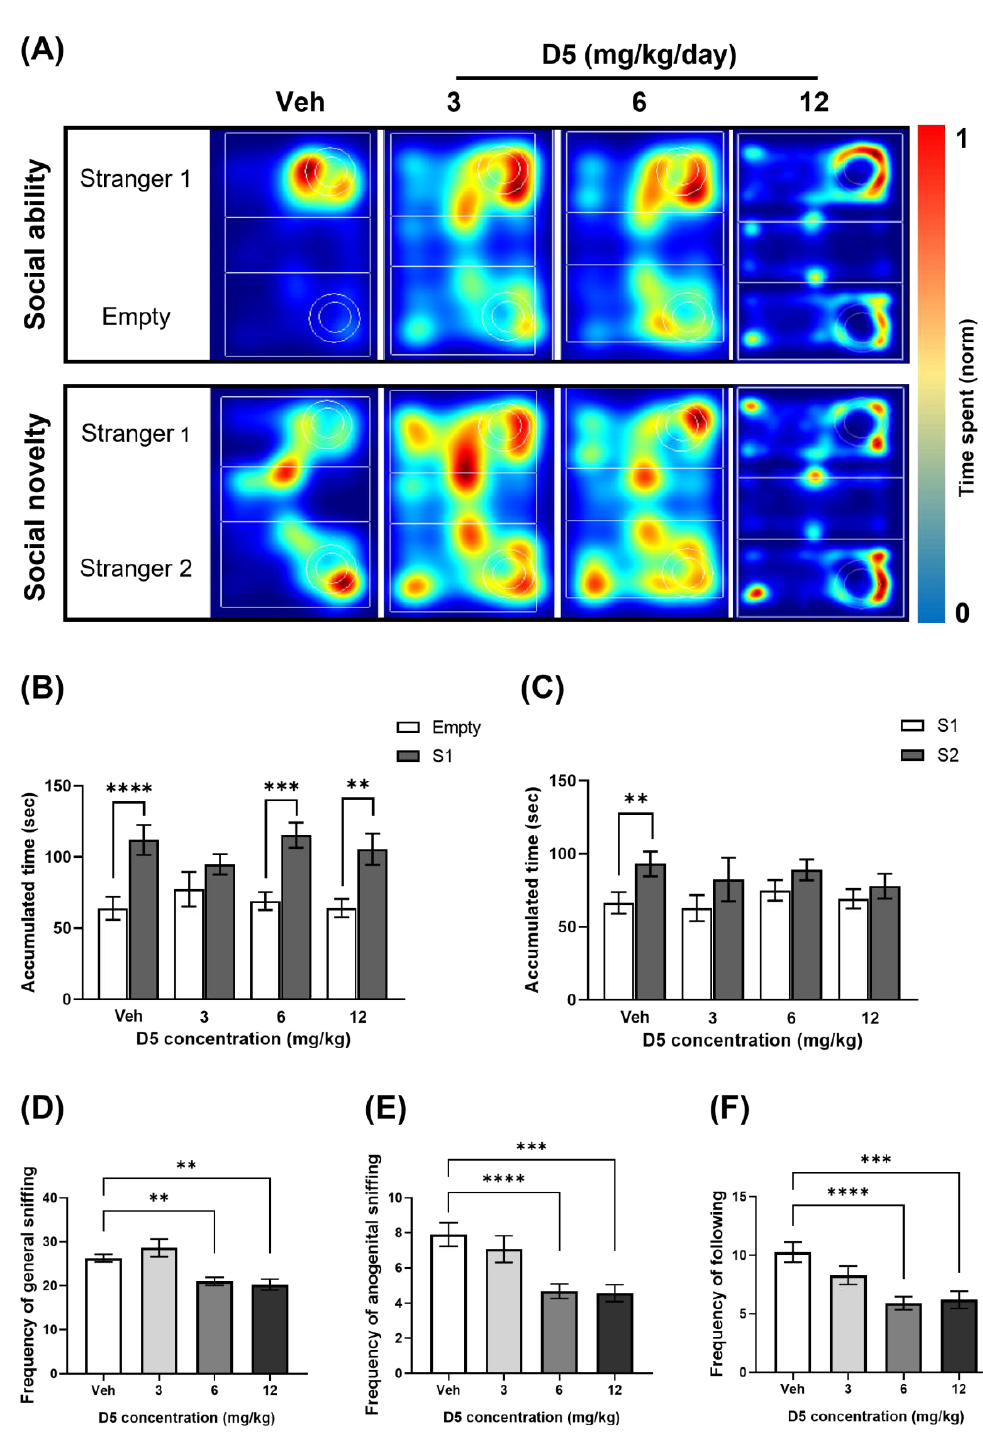
Figure 5. Effect of D5 exposure on sociality in offspring mice: ( A ) image of a heatmap of the accumulated time at the location around the cylinder-shaped cage in the three-chamber test; ( B ) bar graph of the accumulated time (AT) at the location around the cylinder-shaped cage in the social ability test of the three-chamber test and ( C ) in the social novelty test; bar graphs of the frequency of ( D ) general sniffing and ( E ) anogenital sniffing in the social interaction test; ( F ) bar graph of the frequency of following the social interaction test. Significance was obtained using an ANOVA test. ** p < 0.01, *** p < 0.001 and **** p < 0.0001 vs. vehicle. Each value is expressed as the means ± SEM. Vehicle ( n = 20), D5 3 mg/kg/day ( n = 14), D5 6 mg/kg/day ( n = 33), and D5 12 mg/kg/day ( n = 30). Veh,